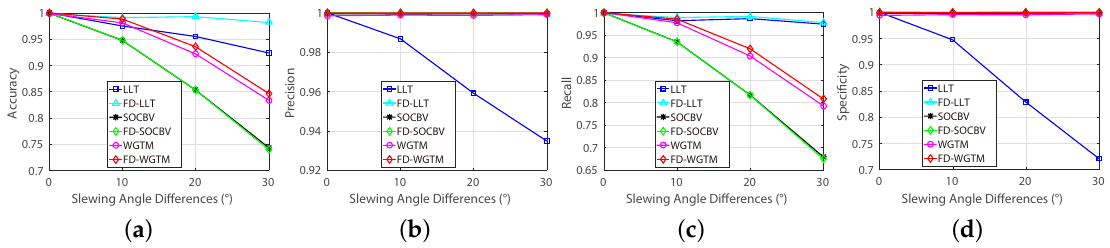
Figure 10. Automatic evaluation results of the three algorithms on datasets with various differences of slewing angles. ( a ) Accuracy. ( b ) Precision. ( c ) Recall. ( d ) Specificity.